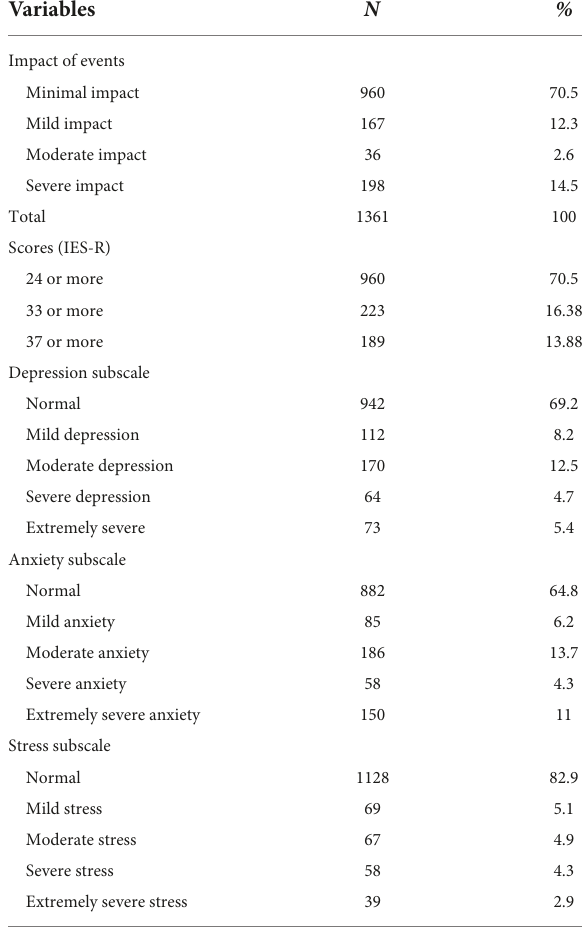
TABLE 1 Psychological impact scores of participants ( N = 1361).